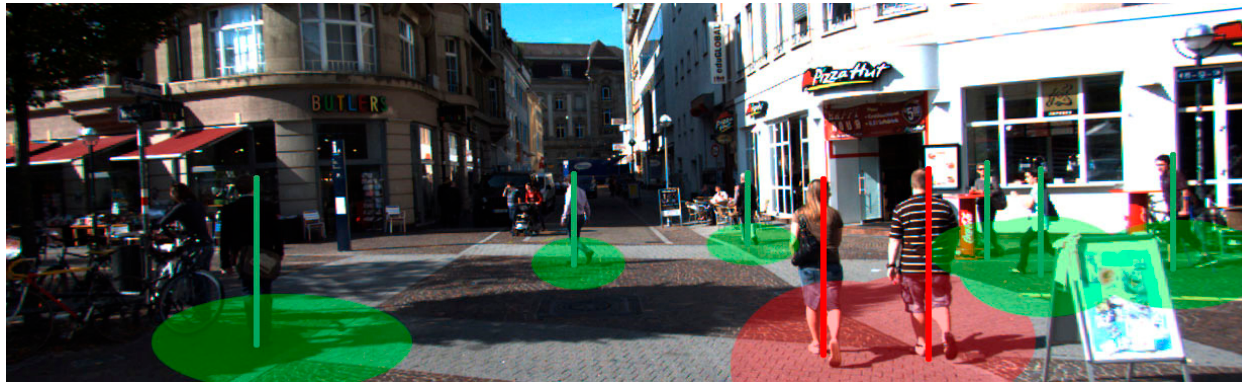
Figure 10. An example scene with various social distancing types.